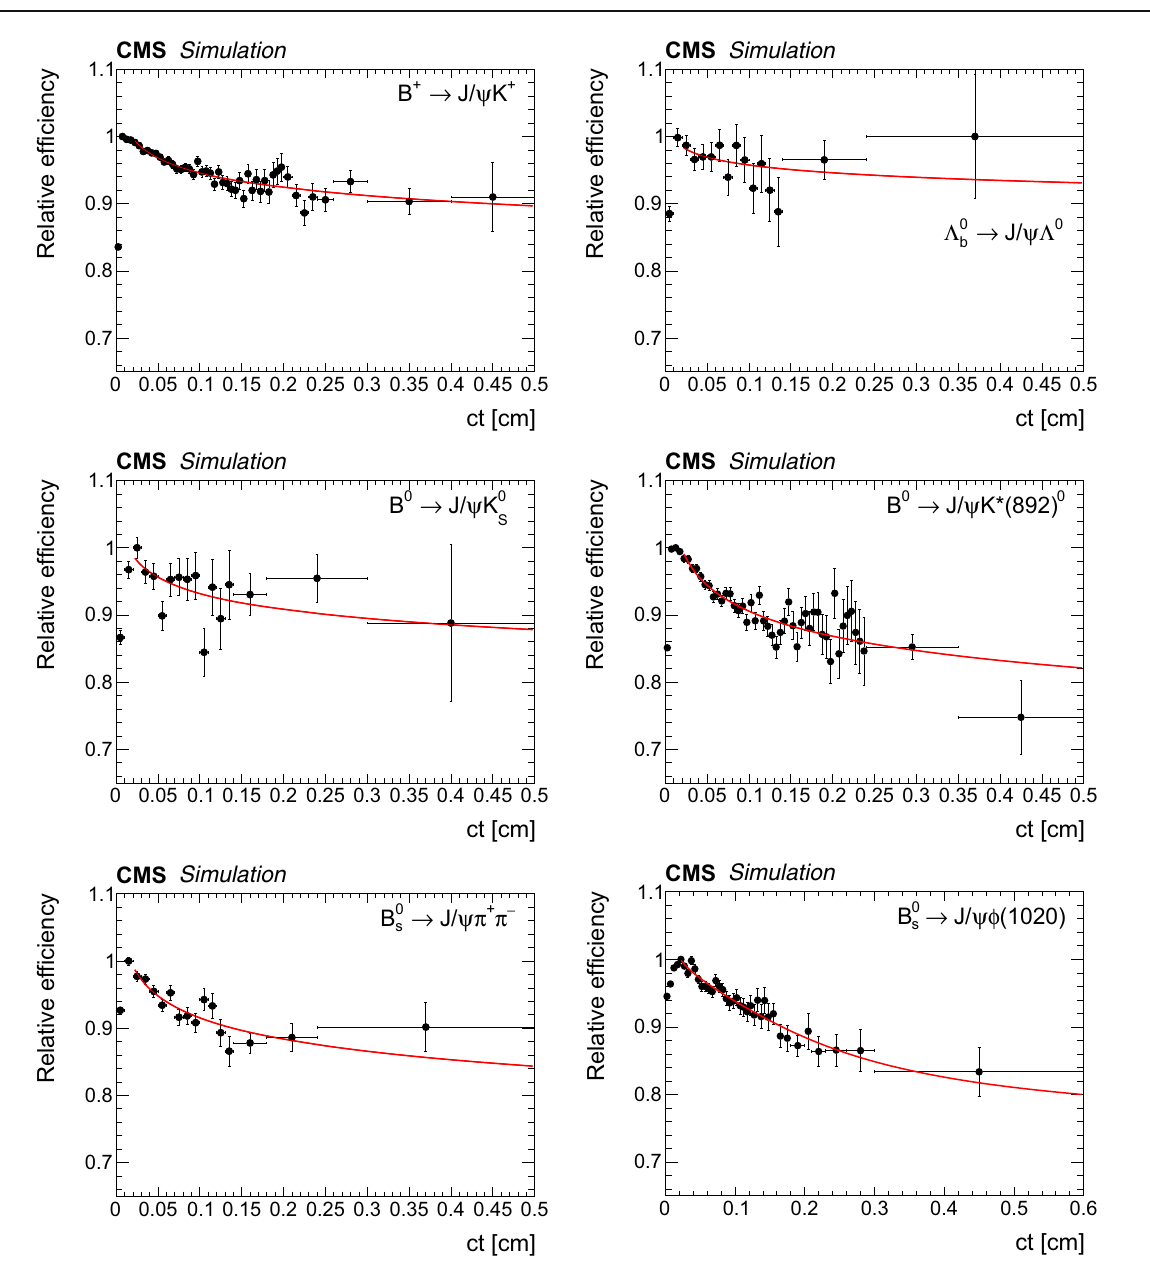
Fig. 1 Thecombinedreconstructionandselectionefficiencyfromsim- (centre left), B 0 → J /ψ K ∗ ( 892 ) 0 (centre right), B 0 s → J /ψπ + π − (lower ulation versus ct with a superimposed fit to an inverse power function left), and B 0 s → J /ψφ( 1020 ) (lower right). The efficiency scale is arbi- → J /ψ(cid:2) 0 (upper right), B 0 → J /ψ K 0 for B + → J /ψ K + (upper left), Λ 0 trary b S